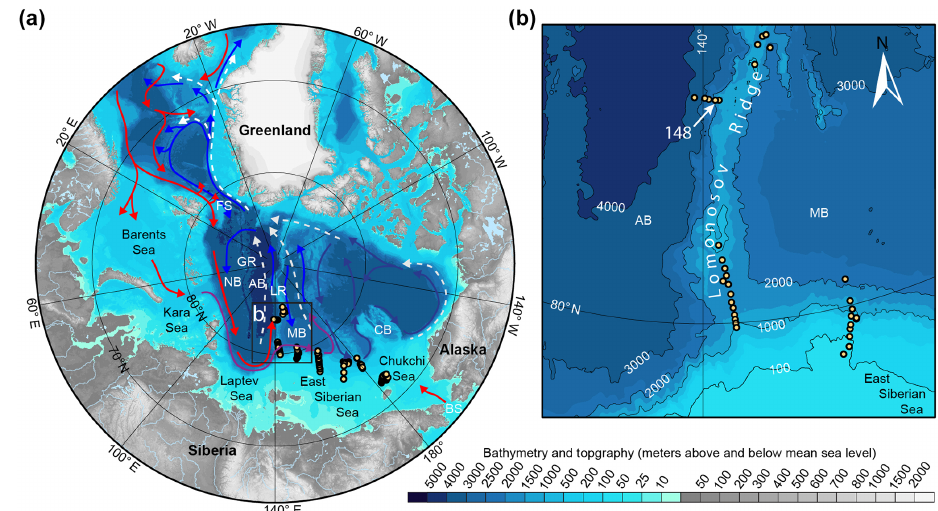
Figure 1. (a) Map of the Arctic Ocean with the major ocean currents. Red arrows: flow of warm Atlantic water and inflow Pacific water through the Bering Strait. Purple: flow of colder Barents Sea branch of the Atlantic water inflow which has been modified when crossing the Barents Sea. Blue: flow of colder and fresher modified Atlantic water. The red and blue arrows also represent the deep water circulation below the warm core of Atlantic water. White dashed arrows: flow of low-salinity water in the surface layer and halocline. Abbreviations: Lomonosov Ridge (LR), Fram Strait (FS), Bering Strait (BS), Nansen Basin (NB), Amundsen Basin (AB), Makarov Basin (MB), and Canada Basin (CB). Yellow dots show the positions for all CTD stations during the SWERUS-C3 expedition. (b) Details of the special study area of the LR including the CTD stations. Note the position of station 148 which is referred to in the text. For further information on station numbers, see Fig.